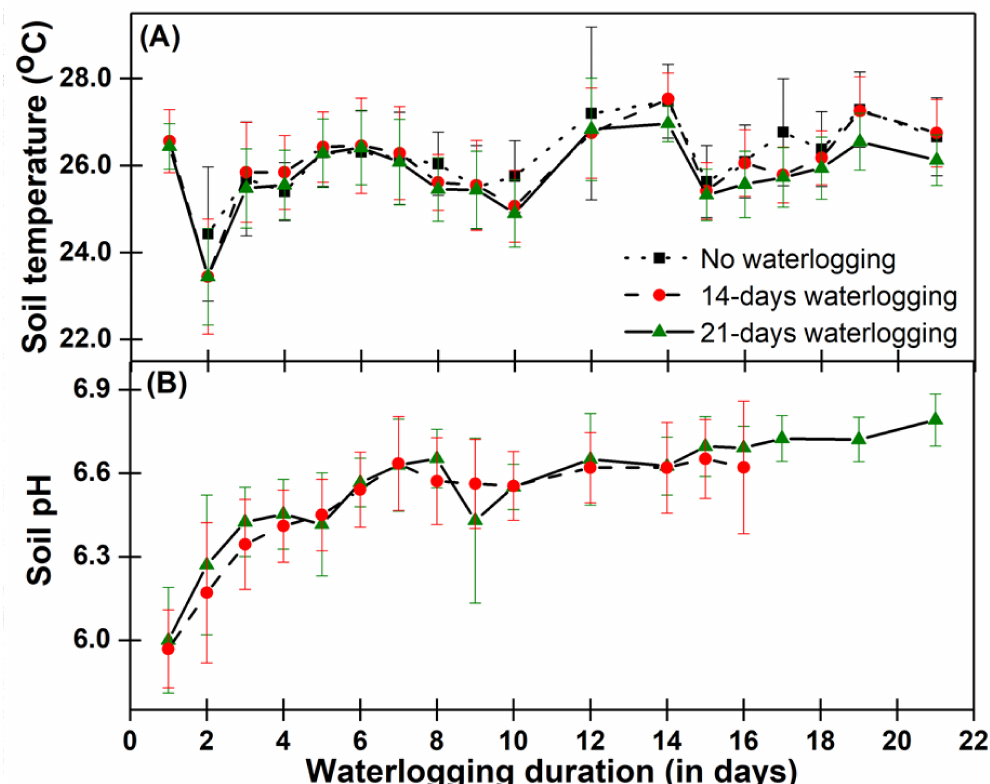
Figure 2. Changes in soil temperature ( A ) and soil pH ( B ) with waterlogging duration after waterlogging initiation. Vertical bars indicate standard deviation for each sampling